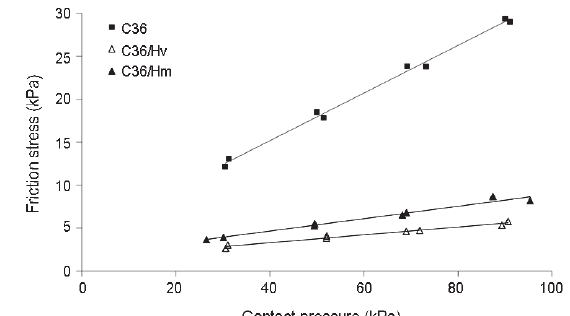
Fig. 8. Evolution of friction stress as a function of contact pressure for C28 with release agent